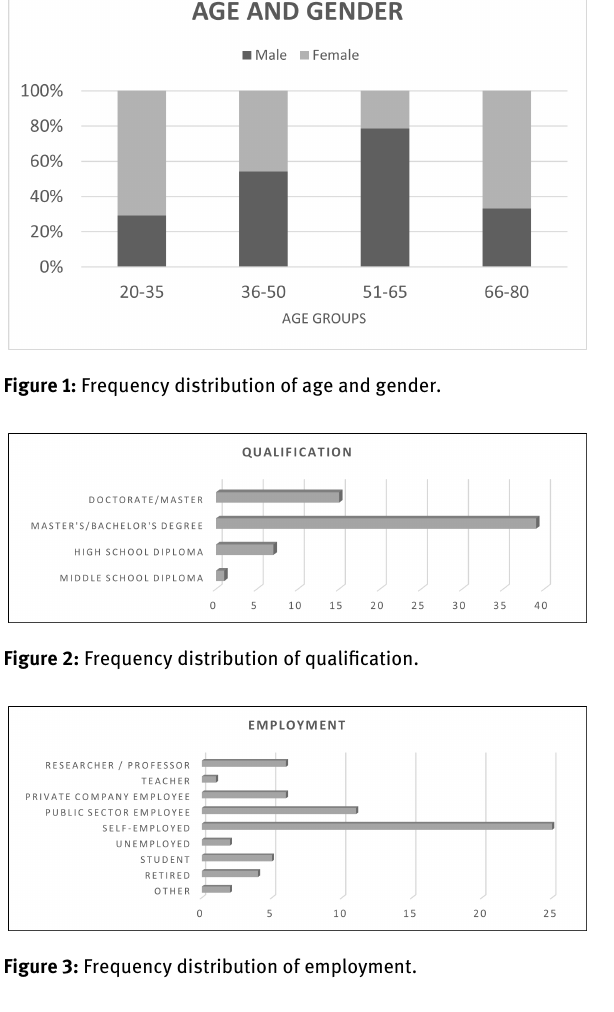
centage of subjects has experienced fiduciary isolation or quarantine (56%) compared to the people who were not personally involved in COVID-19 restrictions (Figure 6).